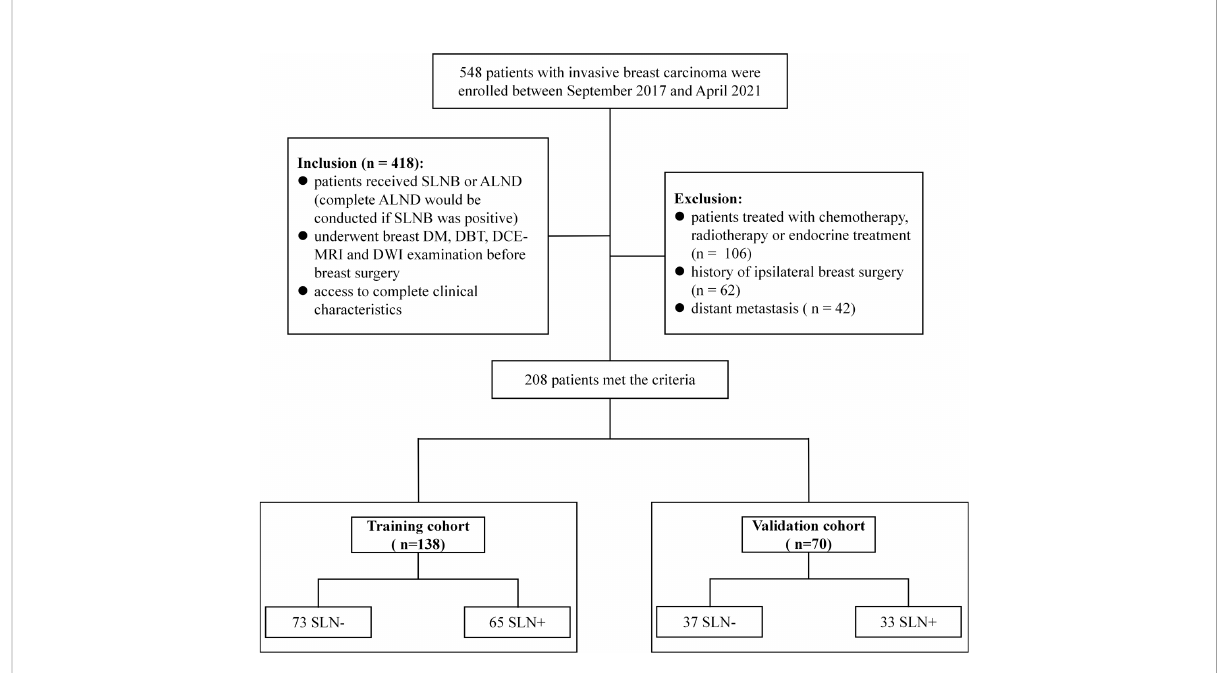
FIGURE 1 Patient recruitment process in this study. SLN-, sentinel lymph node negative; SLN+, sentinel lymph node